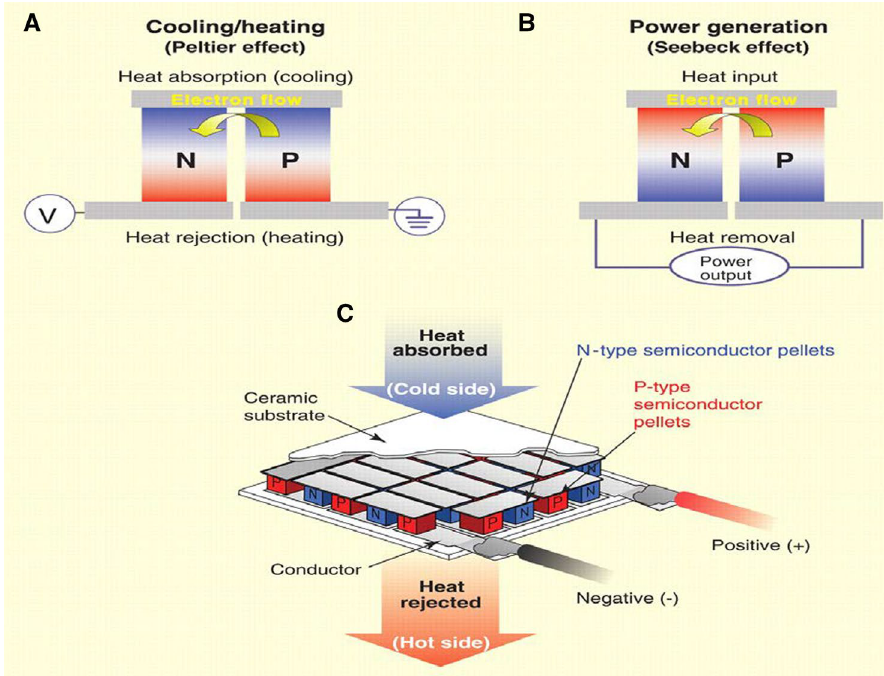
Fig. 4 Water-cooling systems in thermo-electric